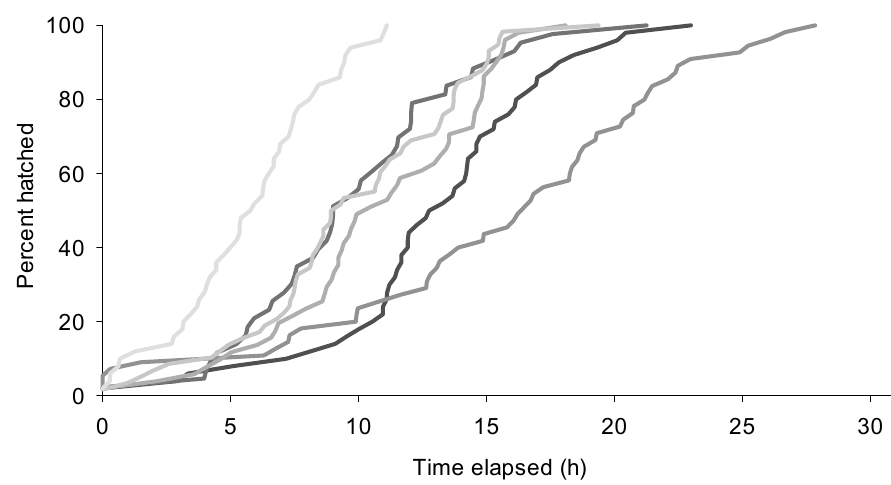
Figure 4. Relationship between time elapsed and percent of caterpillars’ eclosing from six different egg sticks.